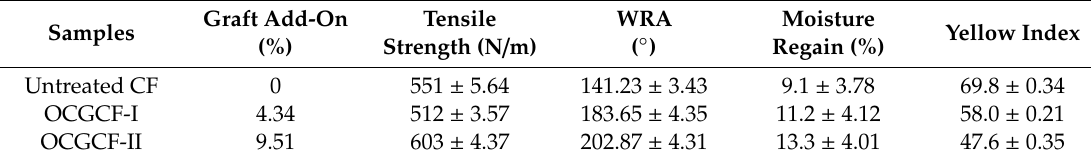
Table 1. The e ff ect of chitosan grafting on the properties of cashmere fibers.